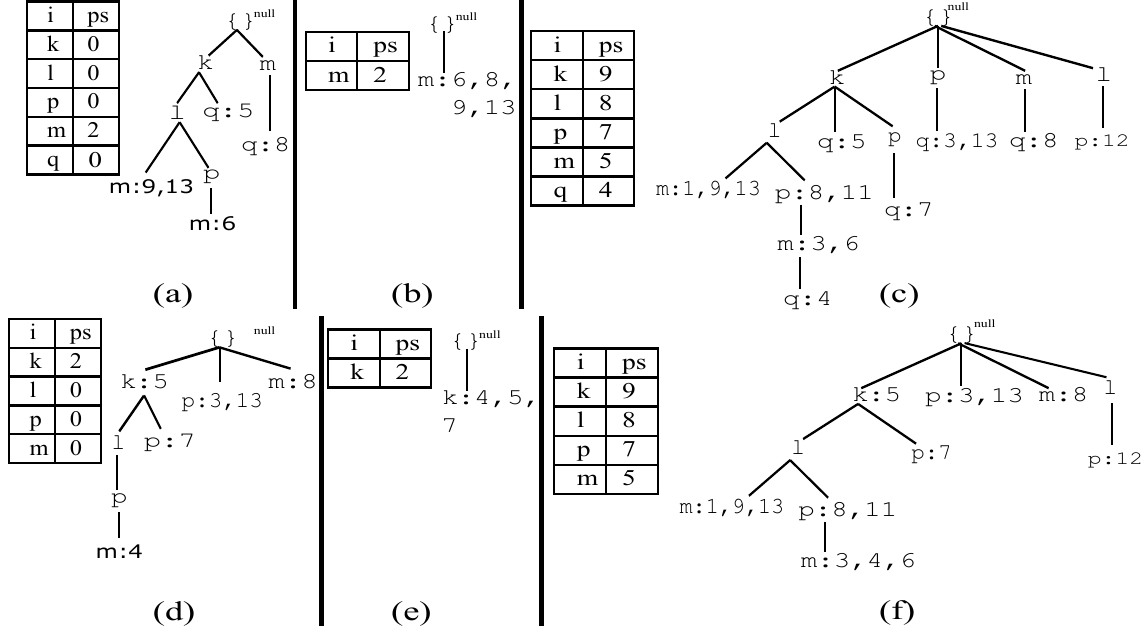
Figure 4. Mining the 3P-tree: ( a ) conditional pattern base of item n ; ( b ) conditional 3P-tree of item n ; ( c ) 3P-tree after pruning item n ; ( d ) conditional pattern base of item q ; ( e ) conditional 3P-tree of item q ; ( f ) 3P-tree after pruning item q . Table 3. The partial periodic patterns that were generated by mining the 3P-tree using the conditional pattern